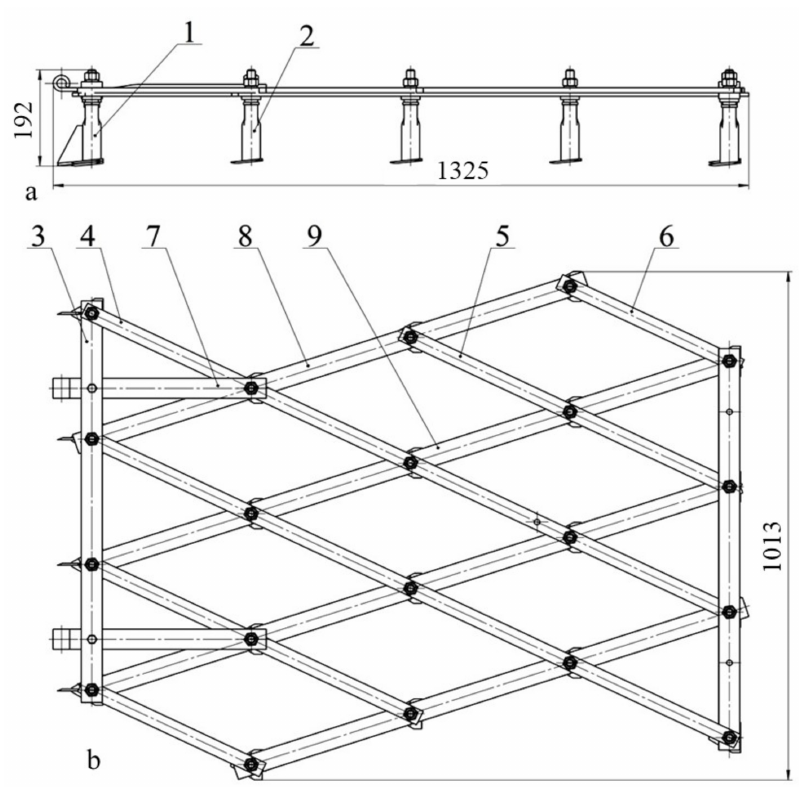
Figure 1. View of the harrowing modular unit equipped with flat-cutting devices: ( a )—side view; ( b )—view from above: 1—front tine; 2—tine; 3—crossbar; 4, 5, 6, 8, and 9—rods forming the reticular frame; and 7—linking rods (measures in